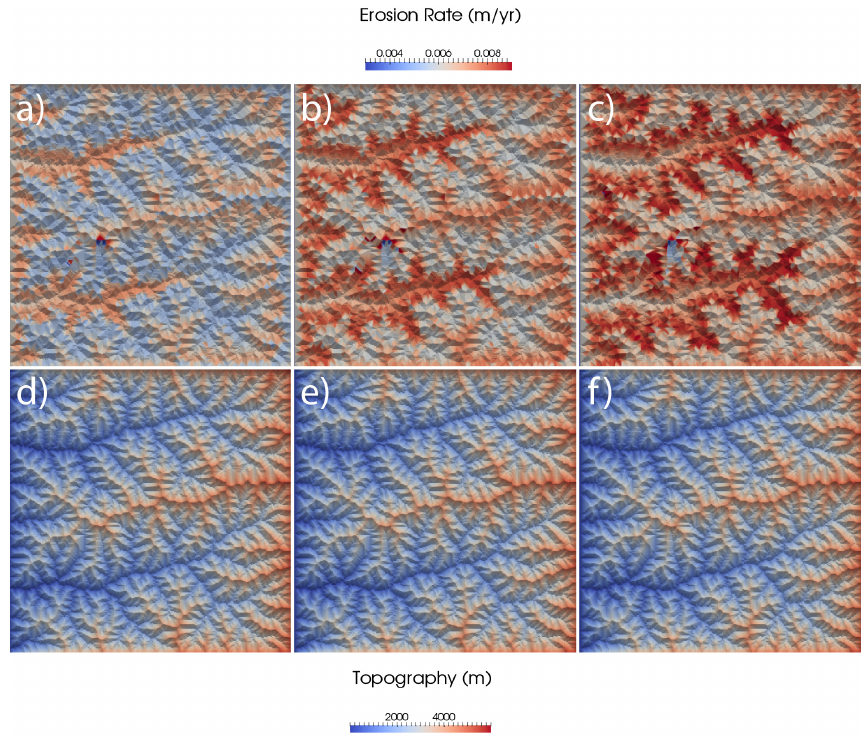
Figure 6. Evolution of (a) – (c) the erosion rate and (d) – (f) the topography predicted by the FastScape landscape evolution model showing the propagation of waves of erosion during an imposed precipitation cycle ( a and d correspond to the time when precipitation rate is at its mean value; b and e correspond to the time when precipitation rate has increased to half of its maximum amplitude, i.e., one-eighth into the precipitation cycle; c and f correspond to the time when precipitation rate has increased to its maximum amplitude, i.e., one-quarter into the precipitation cycle). Note the synchronism between all drainage basins, regardless of their drainage area and/or